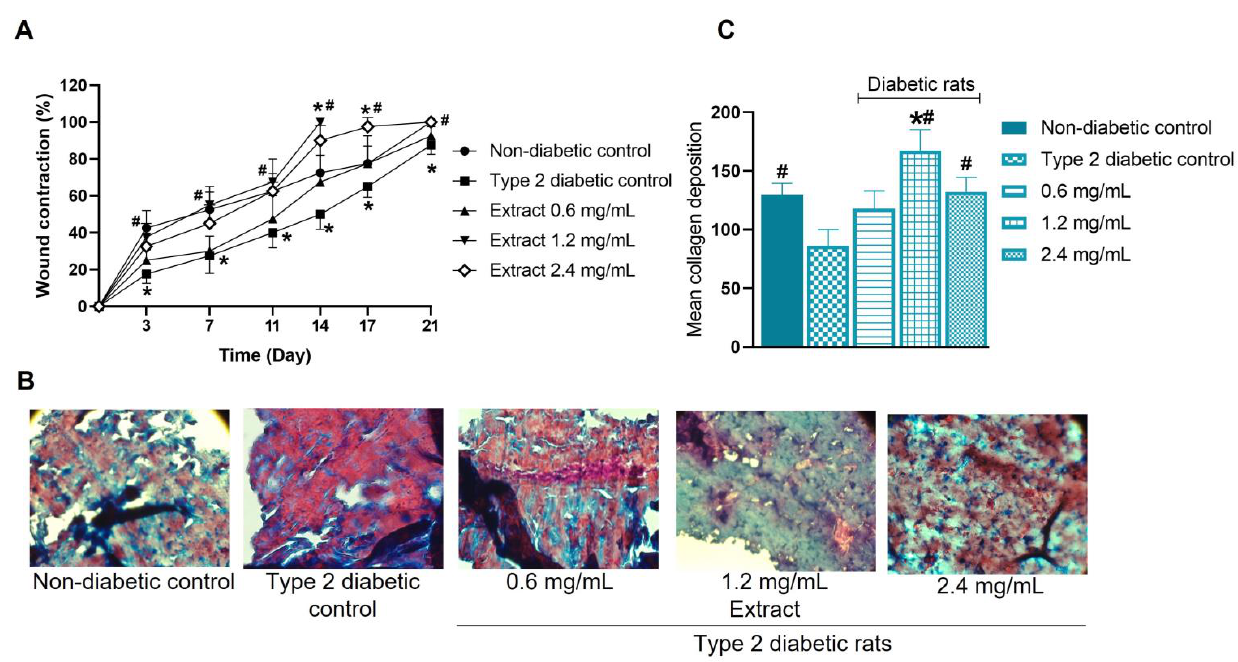
Figure 8. Wound-healing rate ( A ) of type 2 diabetic rats treated with E. hyemale extract (0.6, 1.2, and 2.4 mg/mL) for 21 days. Non-diabetic and type 2 diabetic control groups were treated with physiological saline (0.9%). ( B ) Representative images of healed skin from type 2 diabetic rats were obtained on days 21, 28, 24, 14, and 21 for the non-diabetic group, diabetic group, and diabetic group treated with 0.6, 1.2, and 2.4 mg/mL of the extract, respectively, and stained with Masson’s trichrome. The image shows collagen structures formed in the dermal layer (blue: collagen; red: cytoplasm; dark/blue: cell nuclei). The magnification corresponds to × 40. ( C ) Quantification of collagen deposition. * p < 0.05 versus non-diabetic control group; # p < 0.05 versus type 2 diabetic control